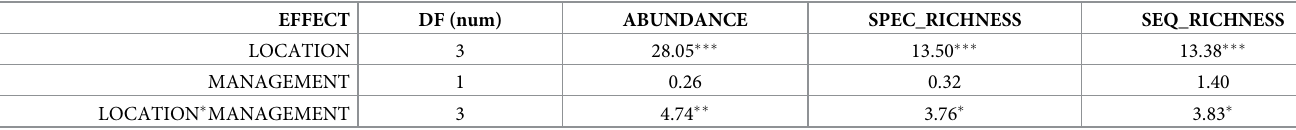
Table 1. ANOVA results for bee specimen